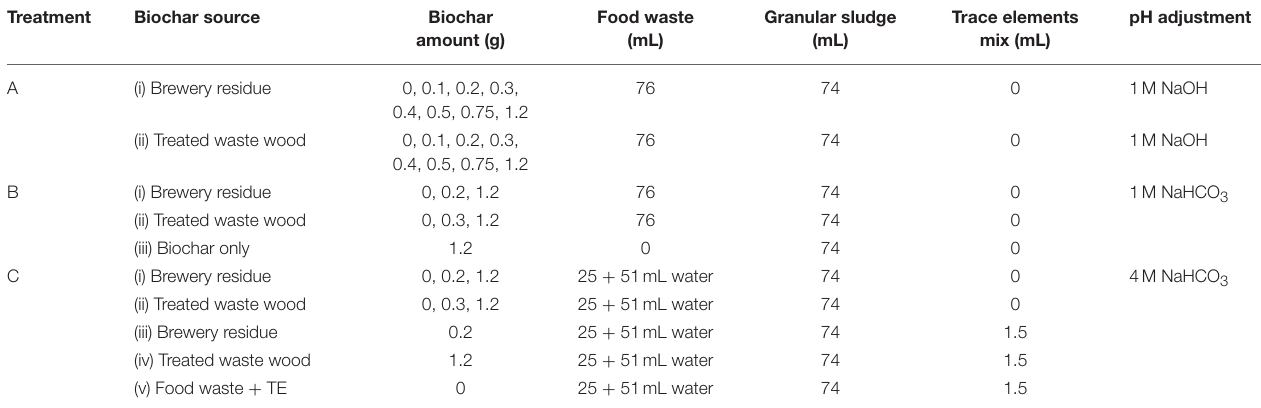
TABLE 1 | Experimental design for batch experiments. Treatment